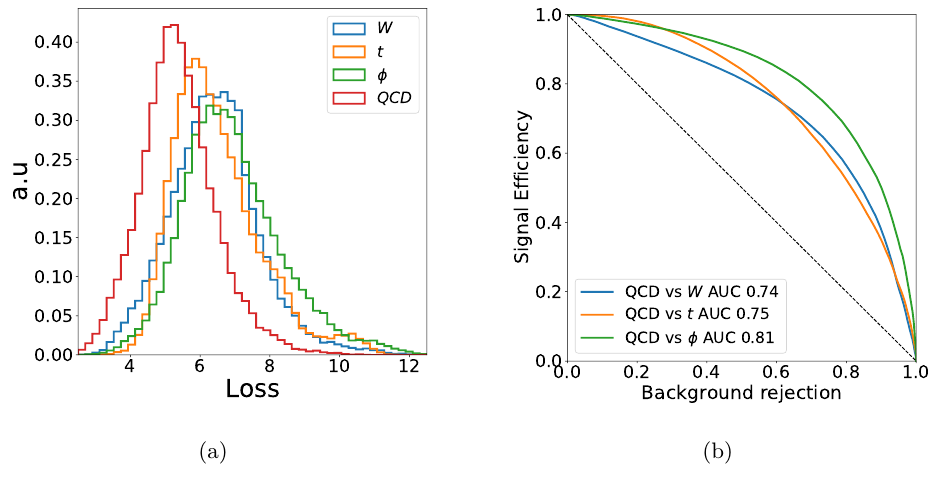
Figure 5 . The loss of the graph-autoencoder (a) and ROC curves (b) for a network trained only on QCD